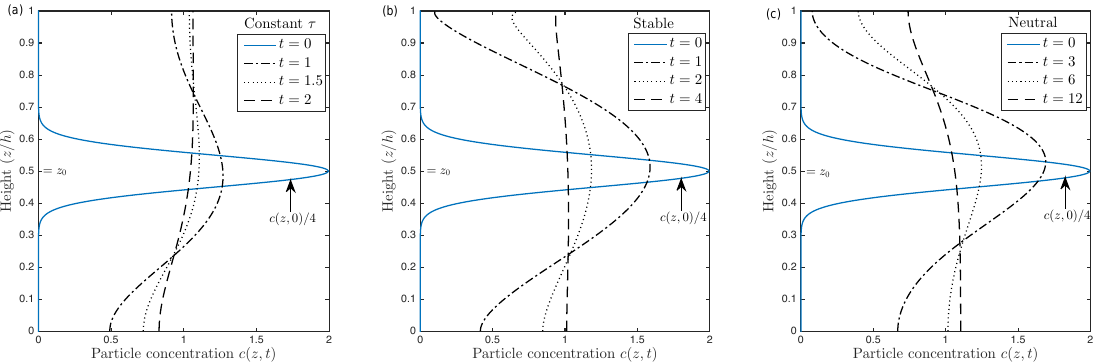
Figure 3. Snapshots of particle concentration c(z,t) from the numerical FPE solutions for the three test-case problems. (a) Constant τ ( t = 0 , 1 , 1 . 5 , 2 h/u ∗ ). (b) Stable ABL ( t = 0 , 1 , 2 , 4 h/u ∗ ). (c) Neutral ABL ( t = 0, 3, 6, 12 h/u ∗ ). For clarity, c(z, 0 )/ 4 is plotted (instead of c(z, 0 ) ) for the initial condition at t = 0 in both